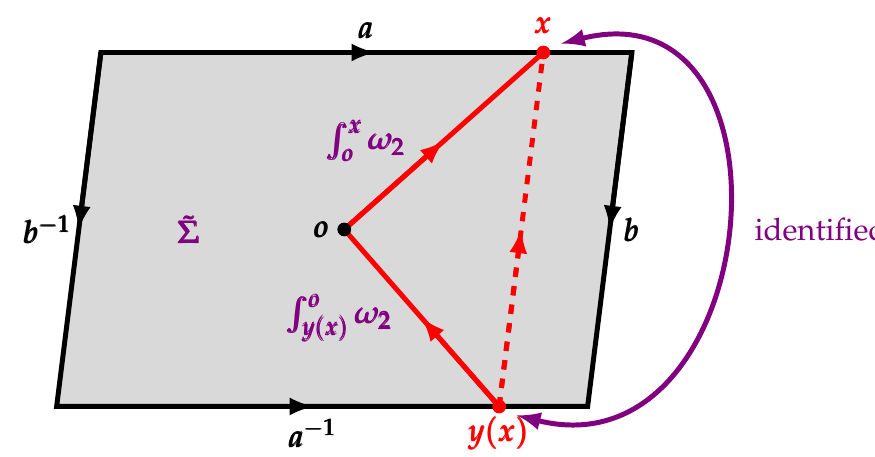
Figure 18. Construction of the integral I b in case g = 1.